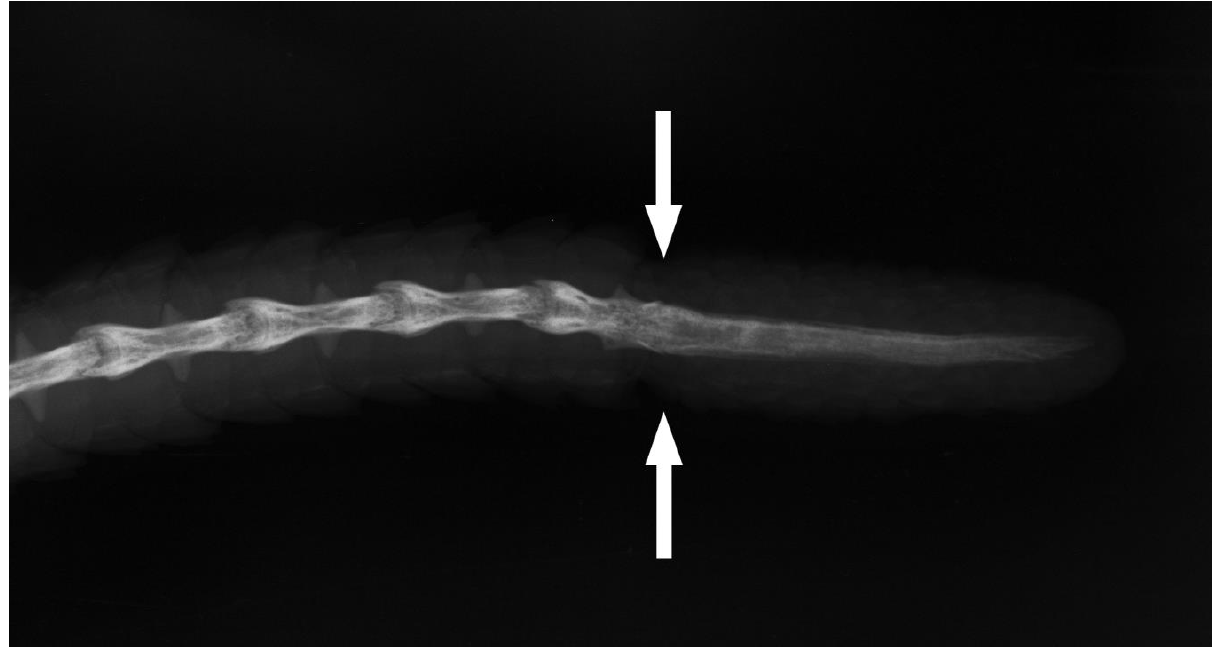
Figure 3. X-ray photograph of Paralaudakia caucasia ZISP 19718 (Turkmenistan) with the pseudoautotomy in the distal part of the tail. The partial ablation at the site of the autotomy and the formation of the cartilaginous tube are shown. Table 3. Incidence of broken and regenerated tails among agamid lizards.